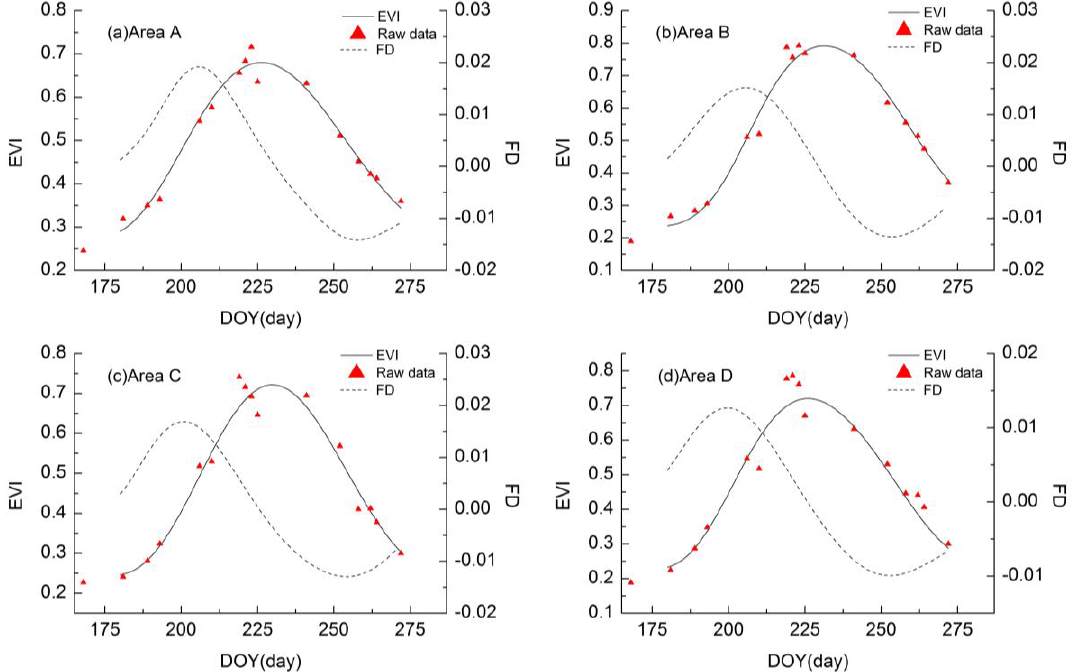
Figure 3. The raw data on EVI from remote sensing image, the fitting curves of EVI time-series by AG function, and their corresponding FD curves for four pixels from the four experiment areas (Area A, Area B, Area C, and Area D), respectively.